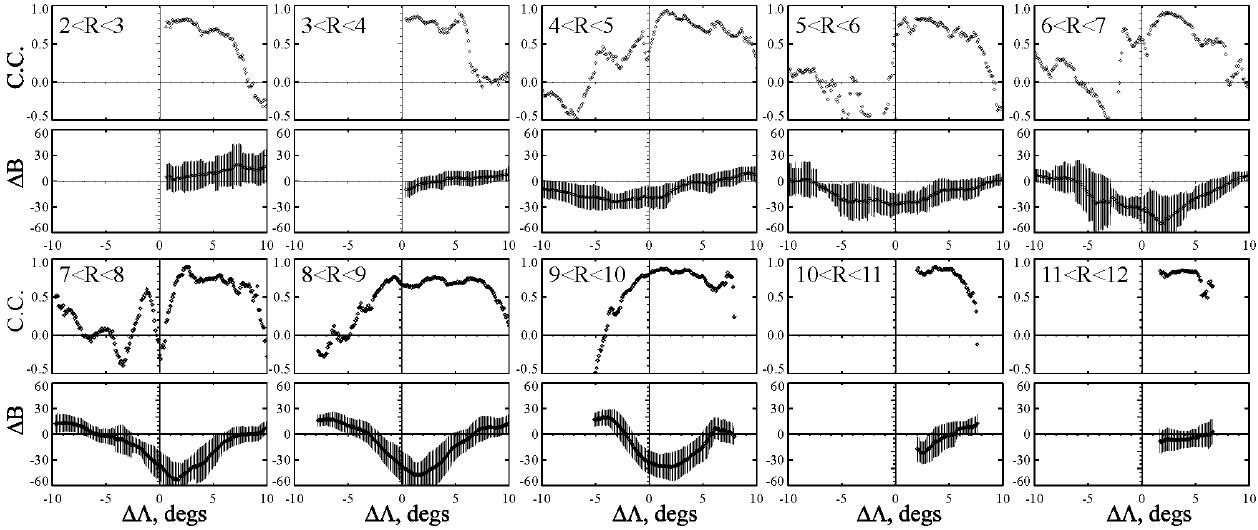
Fig. 6. Same as in Fig. 5, but for the maximal exposure of the polar cusps to the incoming solar wind: 9 ≥+ 15 ◦ and 9 ≤− 15 ◦ for the northern and southern polar cusps, respectively. (The “summertime” case